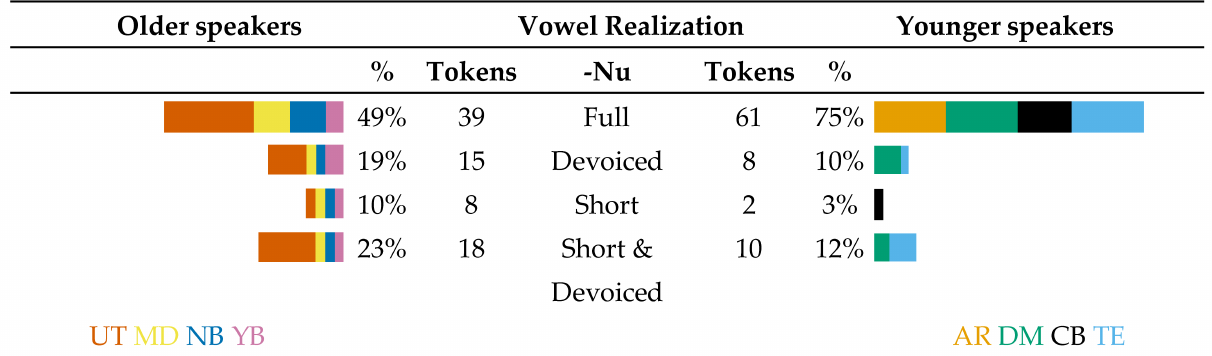
Figure 7. Realization of final vowel when present. Colors refer to individual speakers, ordered youngest to oldest, left to right.